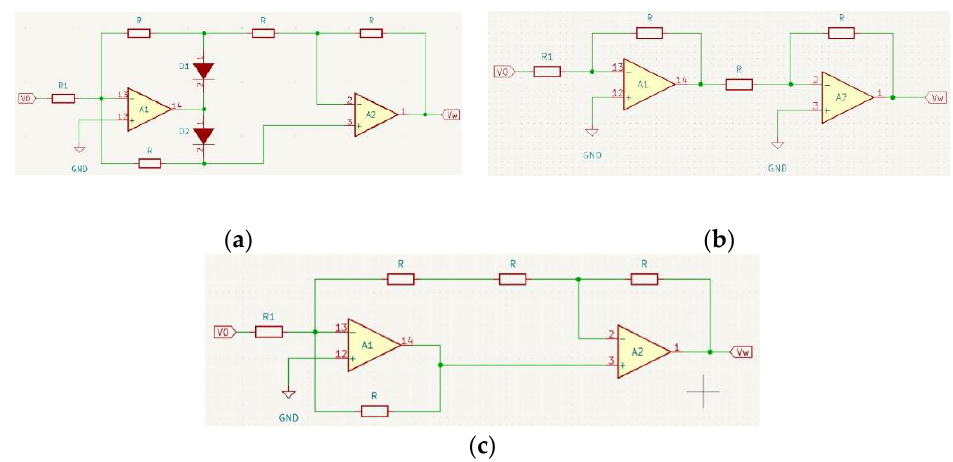
Figure 6. Diagram of a precise full-wave amplifier ( a ), equivalent circuit for simulation of a full-wave rectifier for condition V 0 > 0 ( b ), equivalent circuit for simulation of a full-wave rectifier for the condition V 0 < 0 ( c ).